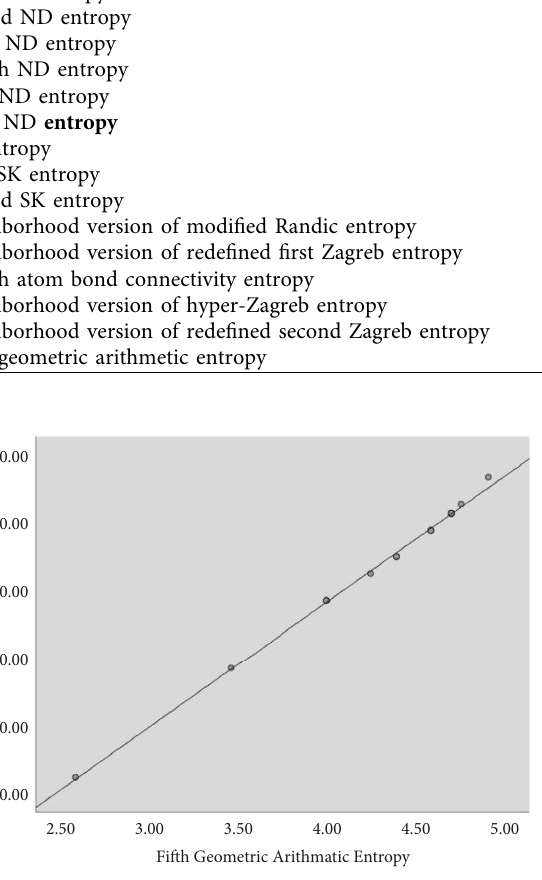
Figure 5: Graphical representation of LRM between critical temperature and the fifth geometric arithmetic entropy.